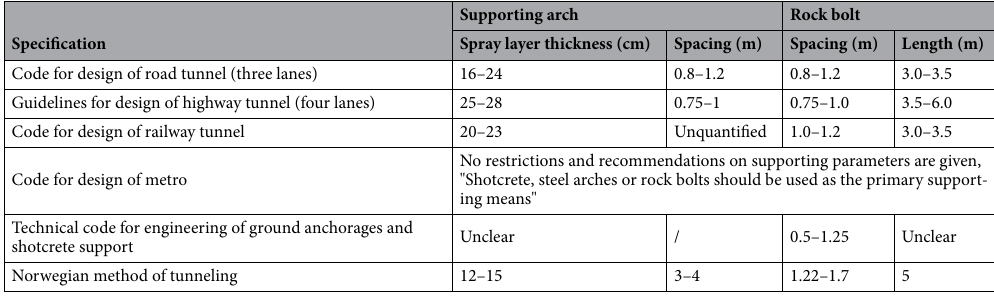
Table 4. Suggestions on initial support parameters given in the codes for level-IV surrounding rock.